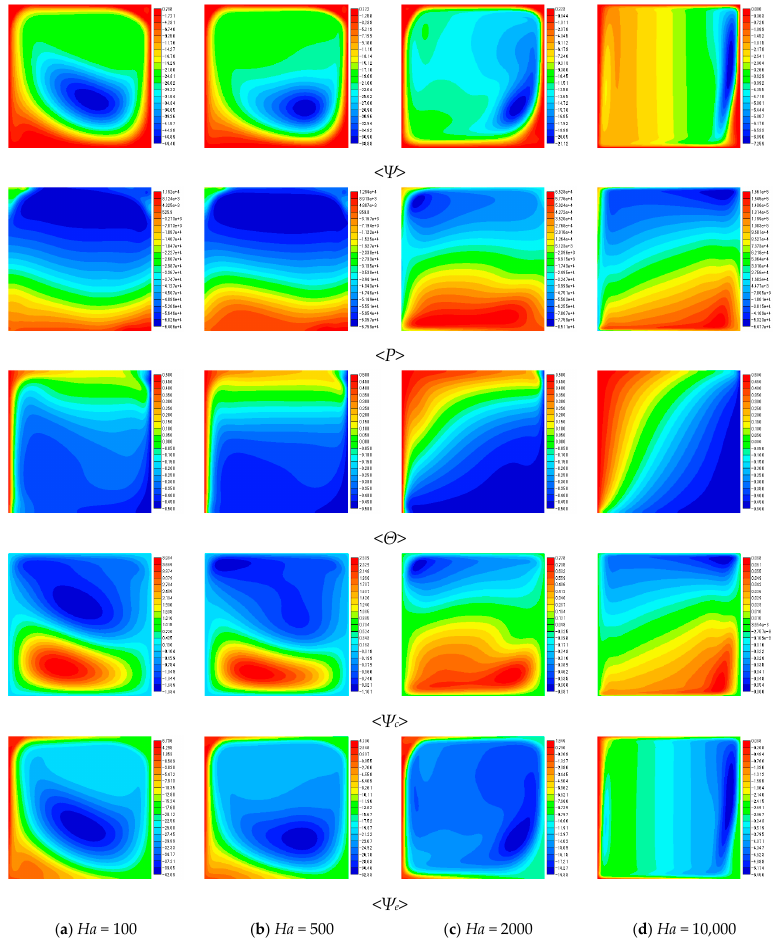
Figure 12. Contour figures for several values of Hartmann number at κ = 0.5 and Ra = 10 7 . From top to bottom, stream function of velocity, pressure, temperature, stream function of electric current density, and electric potential are shown.